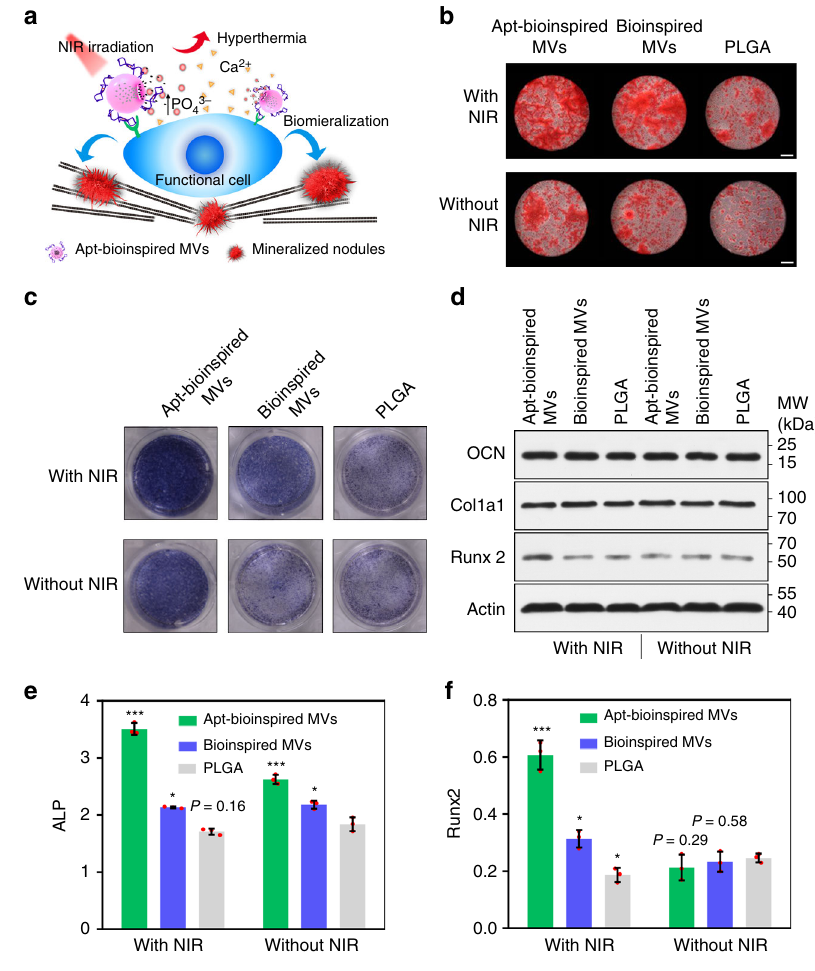
Fig. 4 In vitro evaluation of Apt-bioinspired MVs-guided biomineralization. a Schematic illustration of mechanism of biomineralization. b Alizarin Red staining of osteoblasts cultured with Apt-bioinspired MVs (50ppm), bioinspired MVs (50ppm), and PLGA NPs (50ppm) with or without NIR irradiation (0.2 W cm − 2 ), respectively. Scale bars are 100 μ m. ALP staining analysis ( c ) and western blots analysis of OCN, Col1a1 and Runx2 expression levels ( d ) of osteoblasts treated with Apt-bioinspired MVs (50ppm), bioinspired MVs (50 ppm), and PLGA NPs (50 ppm) with or without NIR irradiation (0.2W cm − 2 ), respectively. The expression level of ( e ) ALP and ( f ) Runx 2 of osteoblasts cultured with Apt-bioinspired MVs (50 ppm), bioinspired MVs (50ppm), and PLGA NPs (50ppm) with or without NIR irradiation (0.2 W cm − 2 ), respectively. Data are means± s.d. ( n = 3), * P < 0.05, ** P < 0.01, *** P < 0.001 (unpaired two-tailed Student ’ s t -test). Source data of d – f are provided as a Source Data fi